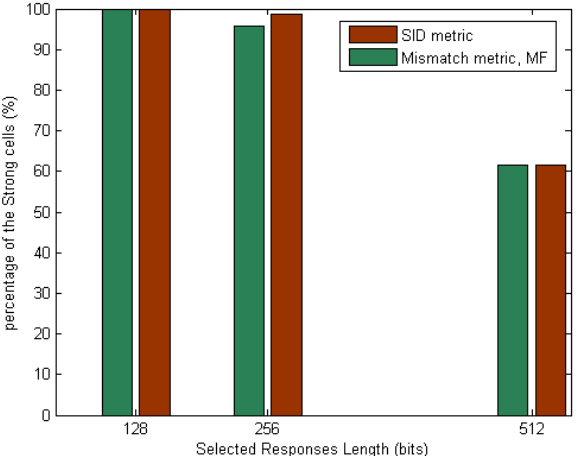
Figure 15. Percentage of reliable cells identified by both metrics when changing different response lengths.